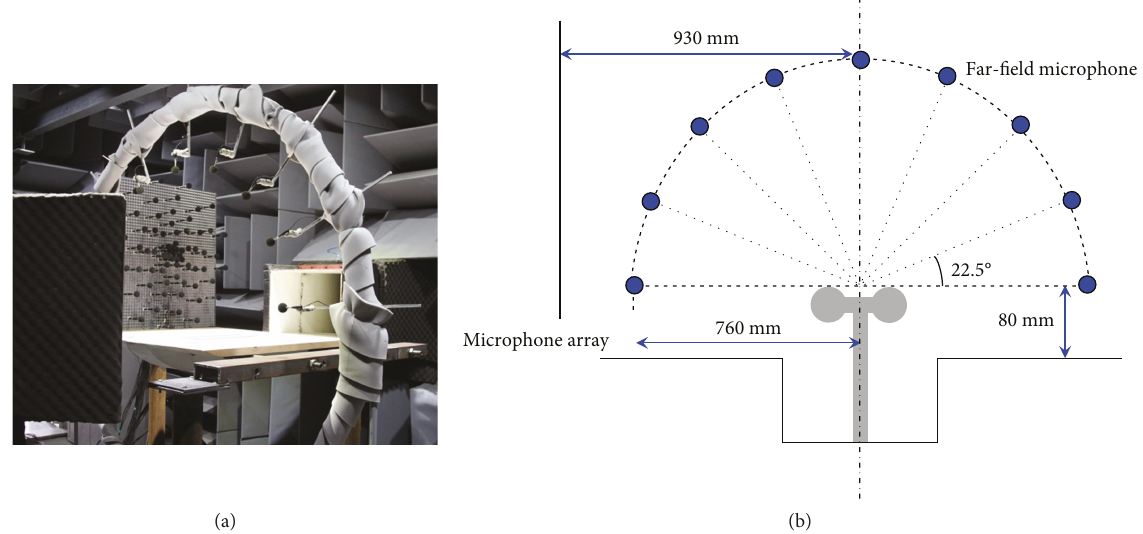
Figure 3: Acoustic measurement setup: (a) view of the installation; (b) schematic of the